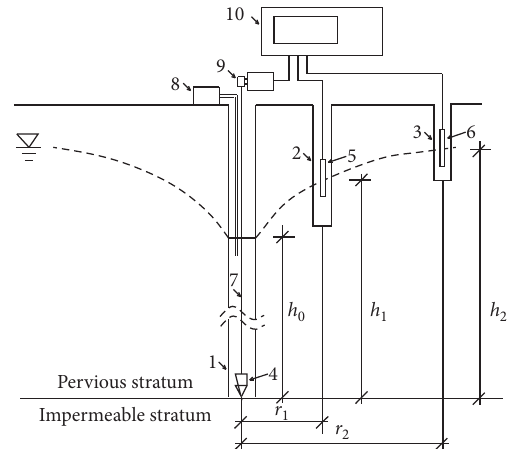
Figure 2: Schematic diagram of continuous detection by the steady-flow pumping test. 1- pumping test hole; 2- observation borehole I; 3- observation borehole II; 4- turbine current meter; 5- water level monitor ① ; 6- water level monitor ② ; 7- electric cable; 8- pumping device; 9- stepper motor; and 10-